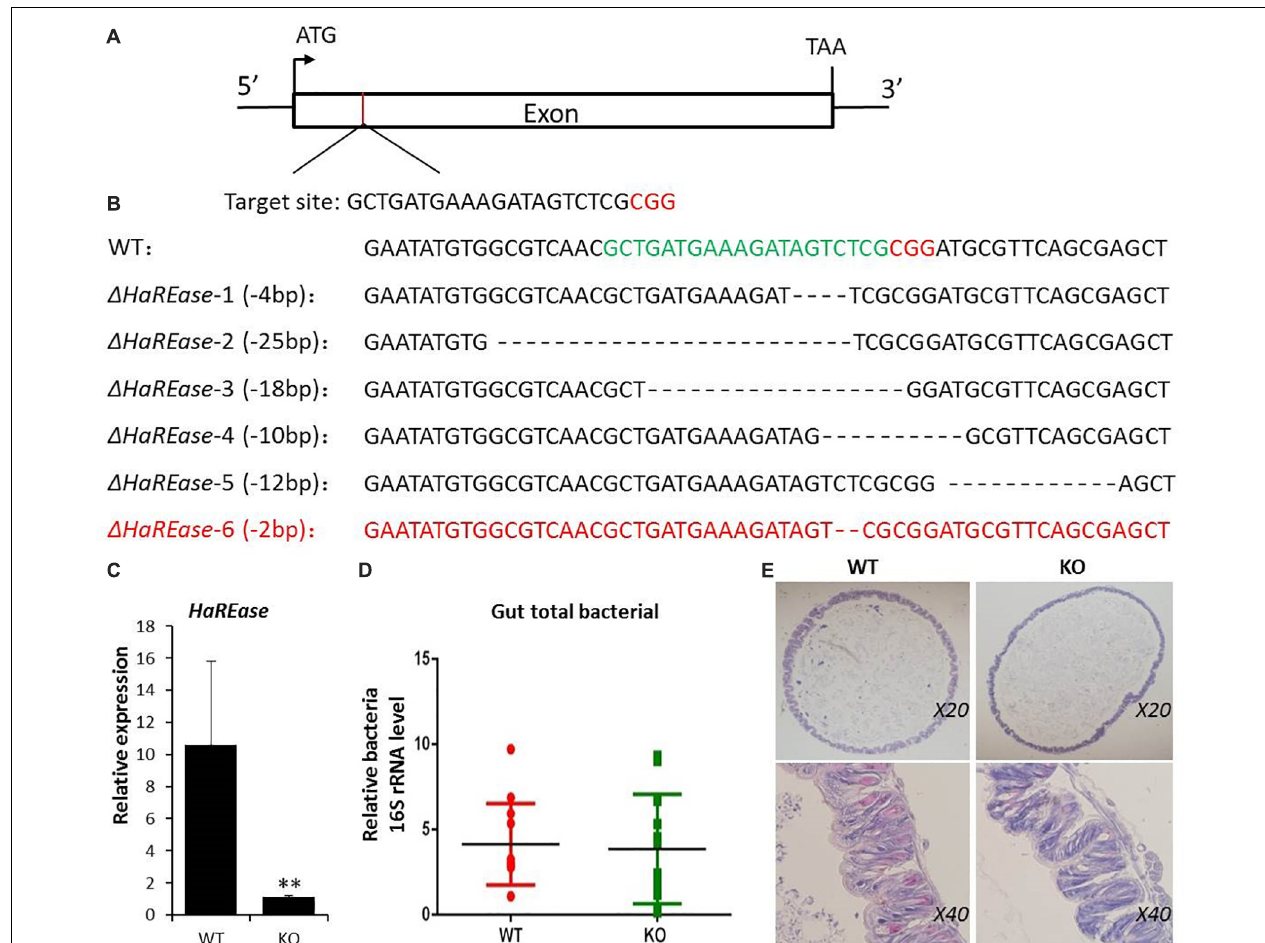
FIGURE 2 | Targeted mutation of HaREase using the CRISPR/Cas9 system. (A) Schematic diagram of the sgRNA targeting site. The box represents the HaREase exon and the black line indicates the gene locus. The sgRNA target site is located on the sense strand of the exon. The protospacer adjacent motif (PAM) sequence is in red. (B) Sequences of the sgRNA target site in WT and six (cid:49) HaREase mutants. The sgRNA target site sequence is in green and the PAM sequence is in red. (C) Confirmation of HaREase gene silencing in KO compared with WT. (D) Total numbers of bacteria in the midgut third instar larvae of WT and KO. (E) Hematoxylin and eosin stained images of the midgut of fifth instar larvae of WT and KO. Data are mean SD, n = 3. ∗∗ P <